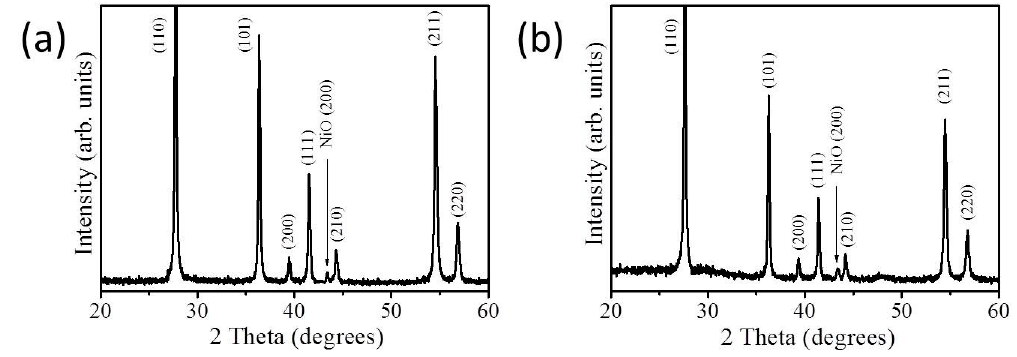
Figure 2. XRD patterns of TiO 2 –NiO composites formed at ( a ) 350 °C and ( b ) 500 °C . The arrow represents the position of NiO Bragg